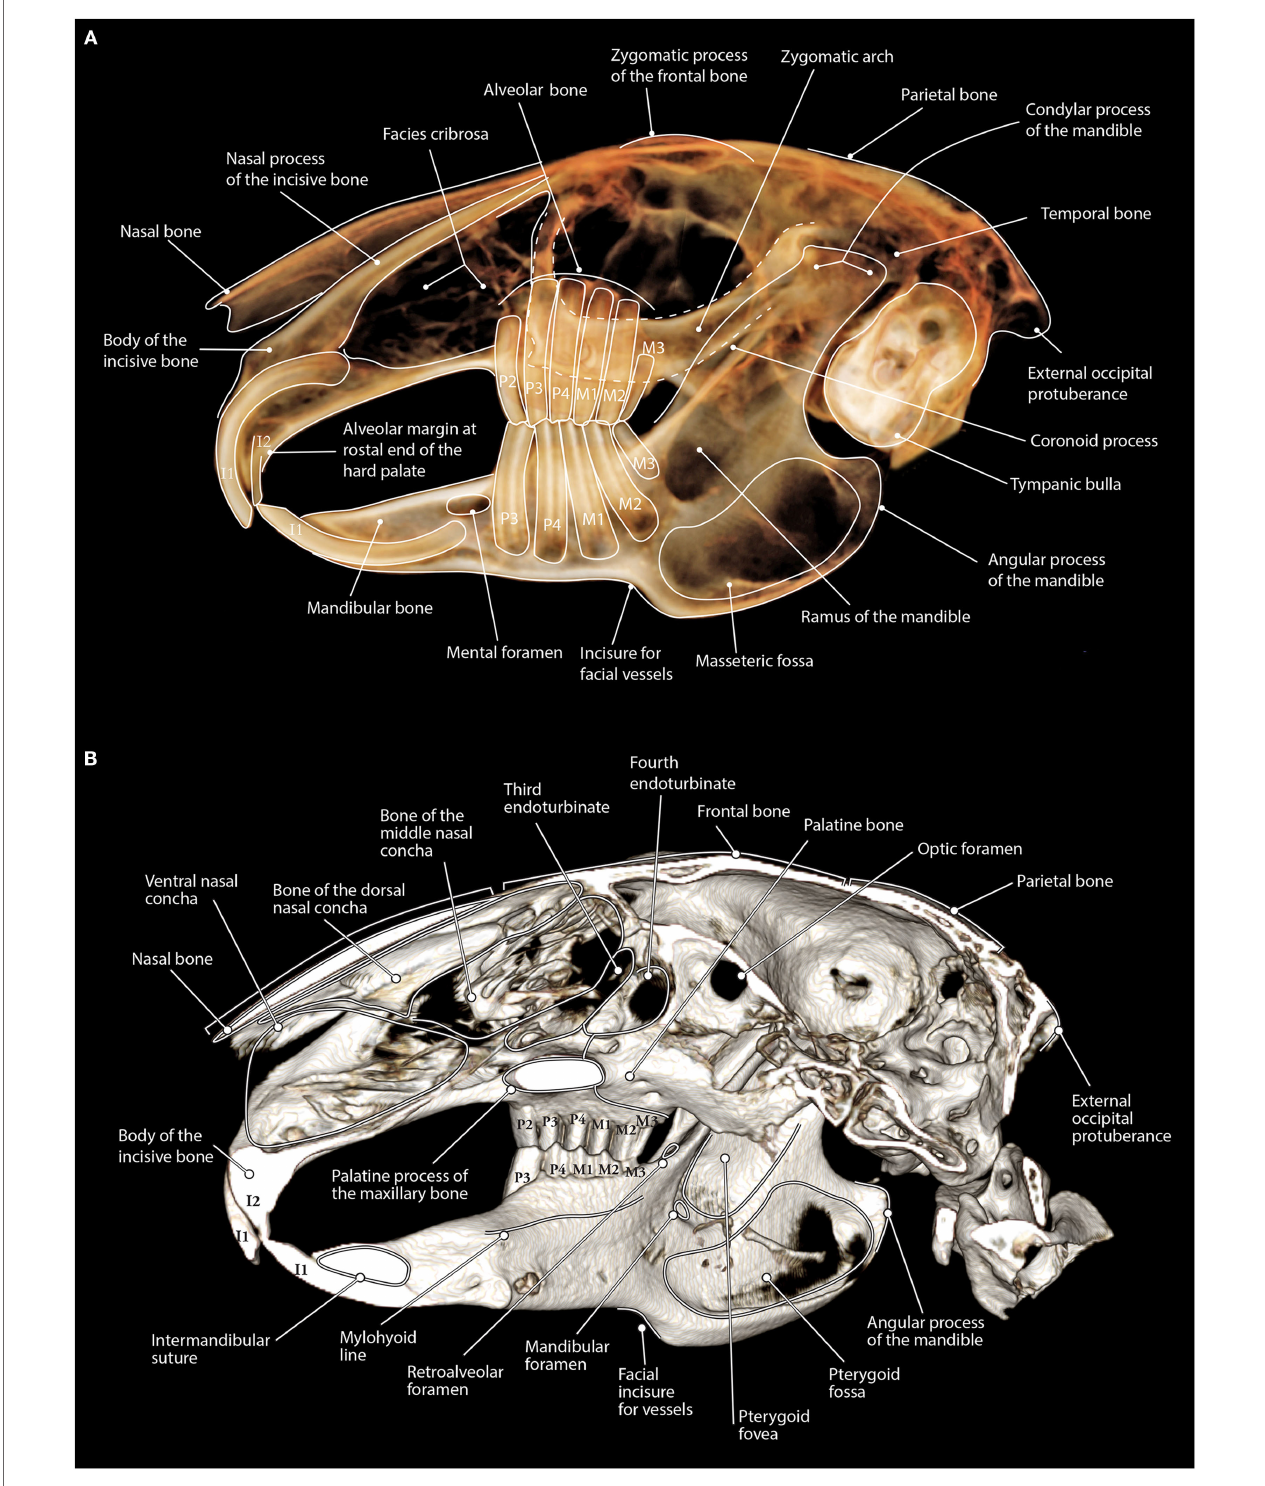
FigUre 1 | (a) Maxillofacial anatomy of a rabbit as viewed on tooth view 3D volume render (a non-shaded surface display) from CBCT data. The lateral aspect of the left side of the skull is displayed with the right side having been cropped from the image. Notice how the zygomatic arch is superimposed over the maxillary premolar and molar teeth. (B) Maxillofacial anatomy of a rabbit as viewed on bone mode 3D volume render (a shaded surface display) from CBCT data. The left half of the skull has been cropped so that the medial portion of the skull can be viewed. Notice the shape of the palatine process of the maxillary bone as this structure can be seen superimposed over the maxillary second, third, and fourth premolar teeth on panoramic images.